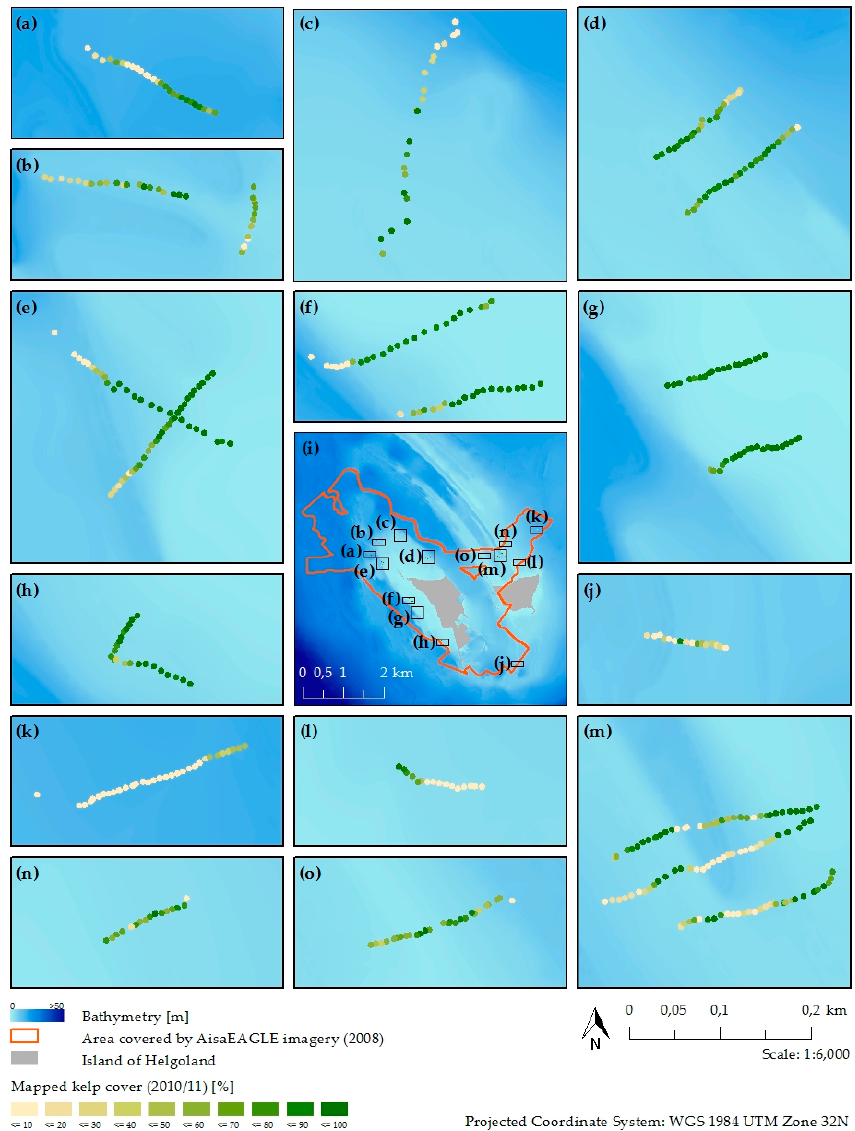
Figure 2. Overview of diving transects ( a – h ), flight stripe cover of the study area ( i ) and overview of diving transects ( j – o ); the colouring indicates the percentage cover of kelp mapped by the divers.